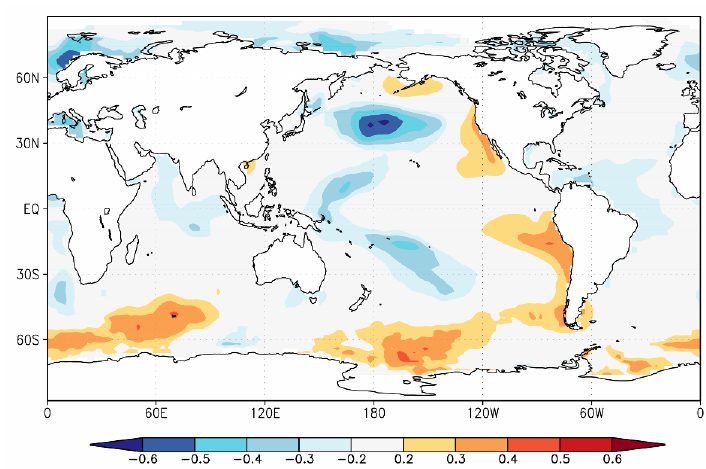
Figure10. Figure 10. Spatial correlations of the reconstructed pMay–cApr scPDSI with global SST during 1957– 2014.